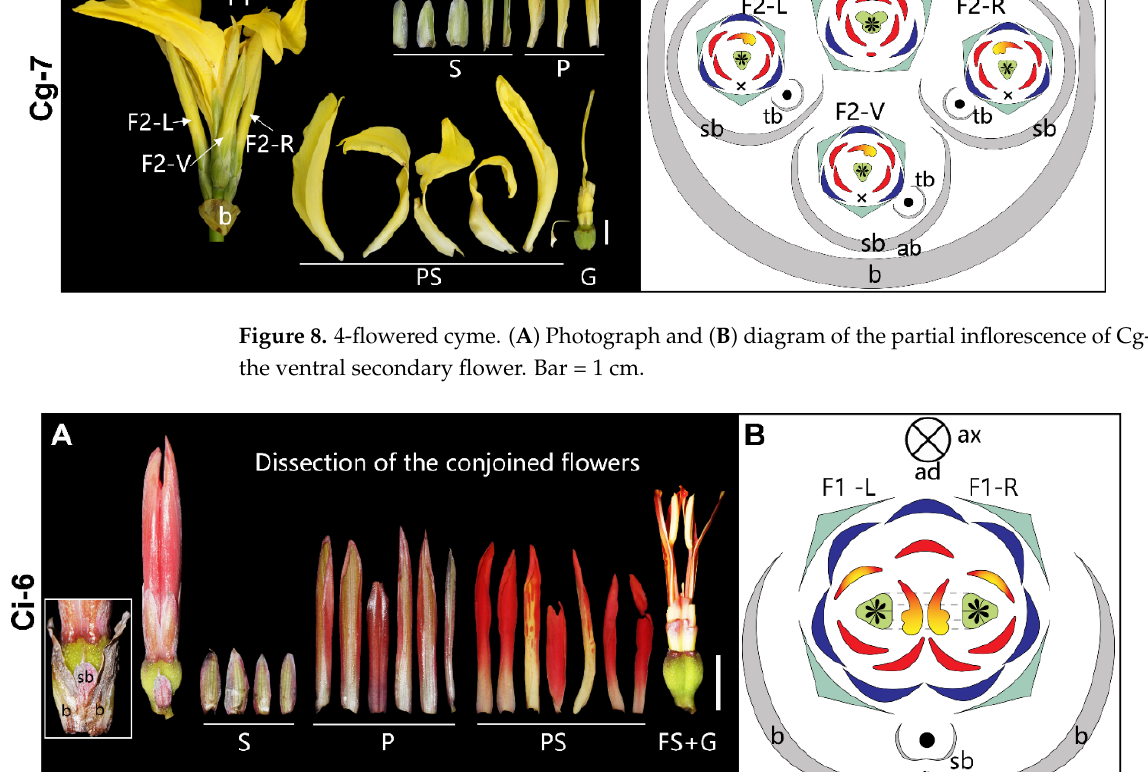
Figure 8. 4-flowered cyme. ( A ) Photograph and ( B ) diagram of the partial inflorescence of Cg-7. F2- V, the ventral secondary flower. Bar = 1 cm.